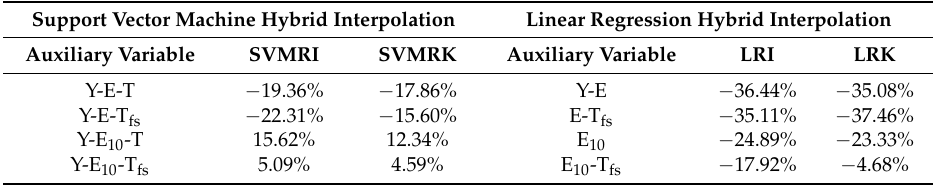
Table 5. RMSE reduction degree of the hybrid interpolation